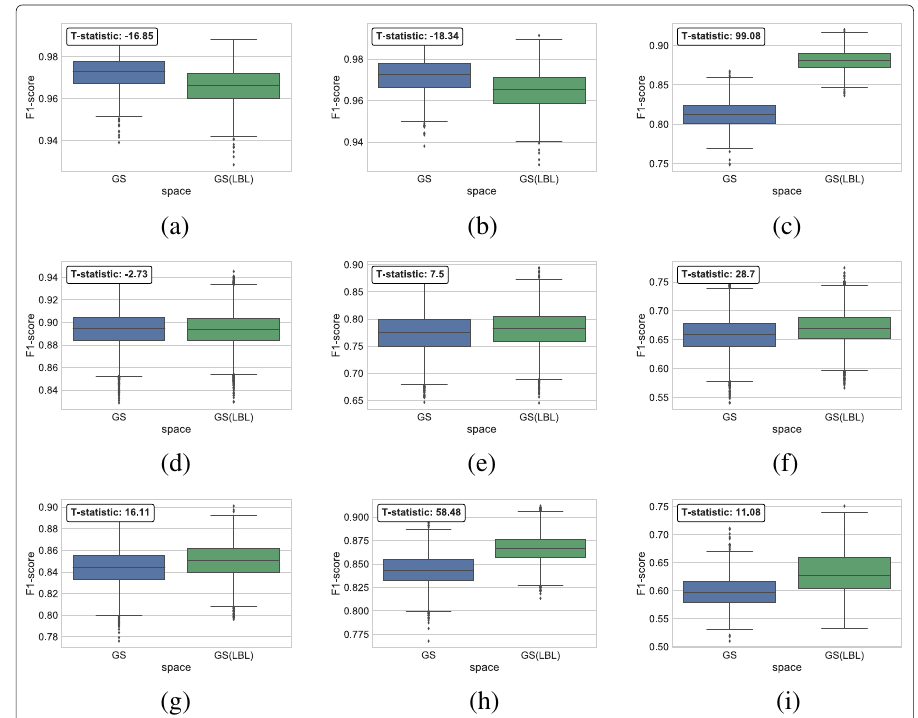
Fig. 4 Accuracy of predictions is presented using 5 × 2 cross-validation F1-scores. Mean accuracy values are shown for real network datasets on GS and GS(LBL) along with the T-statistic which describes the difference in means of the GS and GS(LBL) vectors of prediction probabilities statistically. The network with node attributes is more vulnerable to node re-identification when T-statistic is positive and large. a fb-caltech(gender) b fb-caltech(occupation) c polblogs (party) d fb-dartmouth (gender) e fb-dartmouth (occupation) f pokec-1 (gender) g fb-michigan (gender) h fb- michigan (occupation) i amazon-products